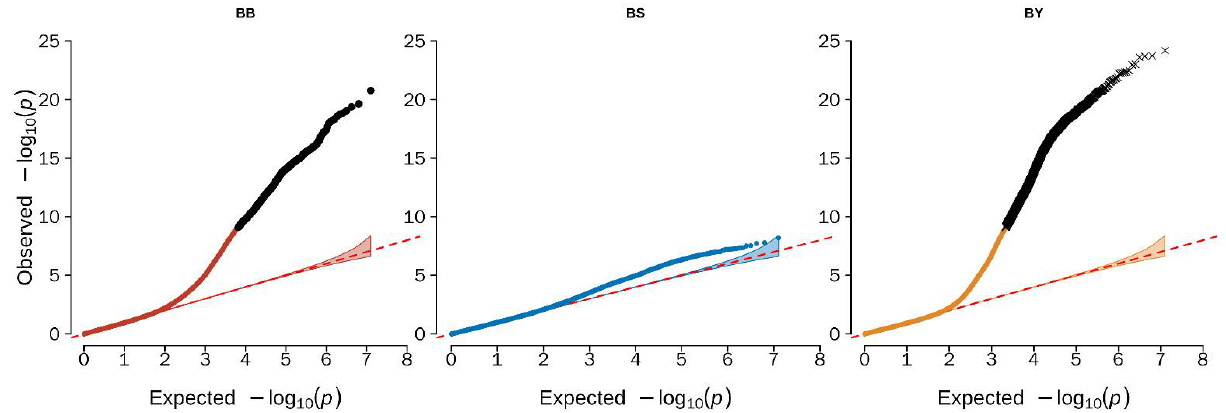
Figure 2. Quantile–quantile (Q–Q) from GWAS for beak color trait in duck. Q–Q plot showing the late separation between observed and expected values. The red lines indicate the null hypothesis of no true association. Deviation from the expected p -value distribution is evident only in the tail area for each trait, indicating that population stratification was properly controlled. BB refers to black beak; BS refers to spotted beak; BY refers to yellow beak.